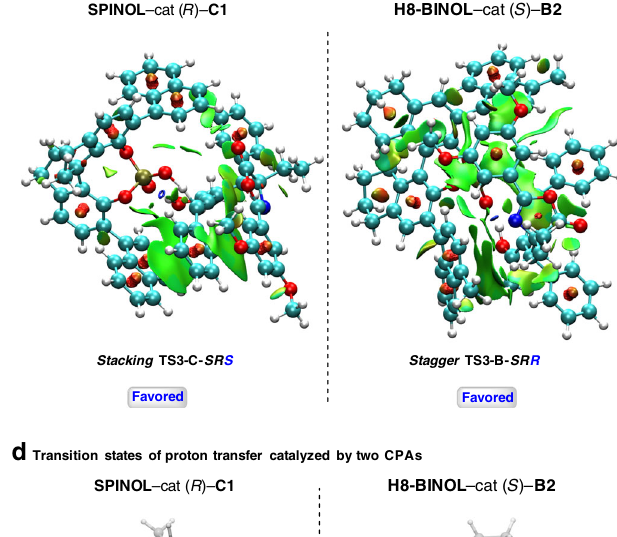
B2 featuring a 1-(4-Me-naphthyl) substitution (over just 1-naphthyl in catalyst B1 ) could improve the diastereoselectivity signi fi cantly (2.7:1 to 10:1, see Table 1). For this catalyst, the ΔΔ E orbital , a high proportion for energy, stabilized for the